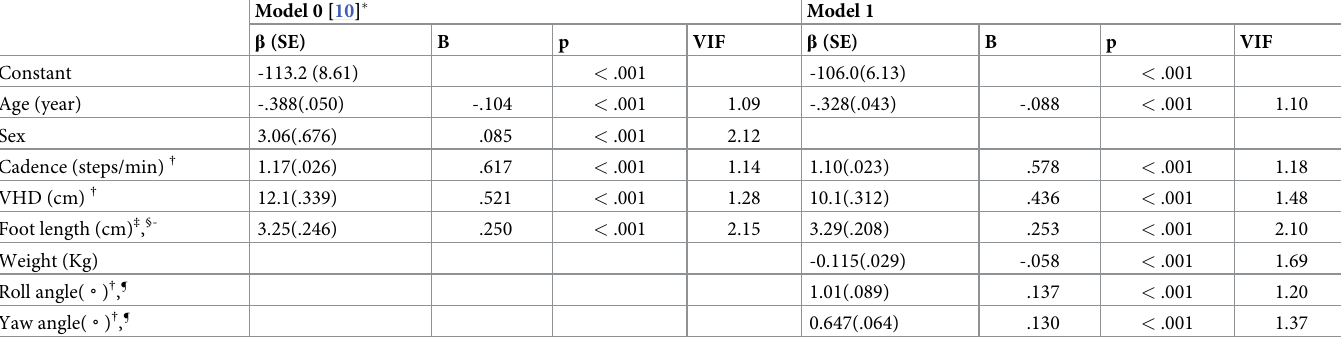
Table 3. Development of the gait speed estimation model by employing the body weight and roll and yaw angles of the center of mass as additional predicting features.